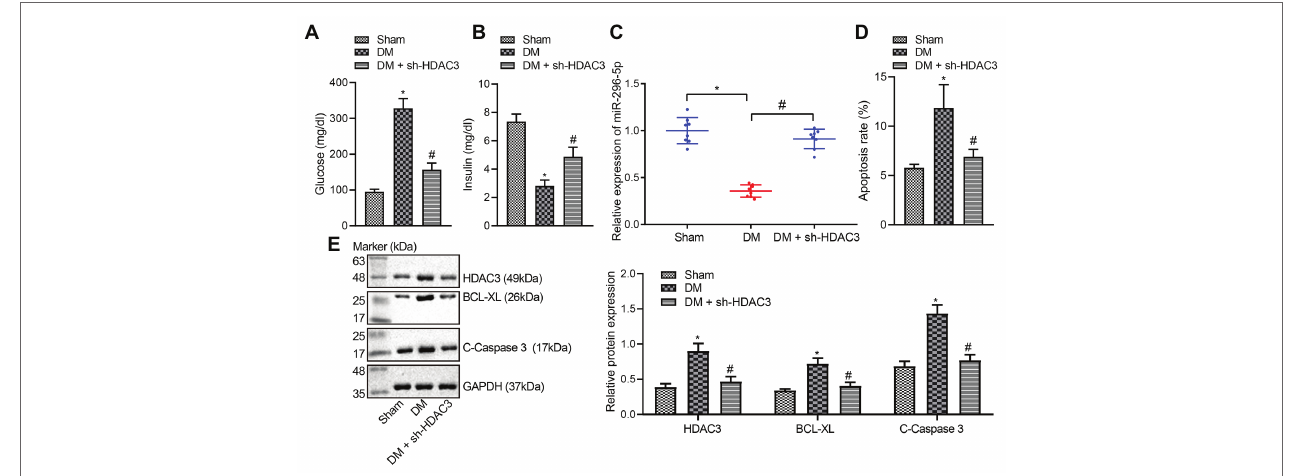
FIGURE 6 | shRNA-mediated silencing of HDAC3 alleviates DM-induced PBMC apoptosis in vivo . (A) Glucose level of rats. (B) Insulin levels of rats. (C) miR-296-5p expression in PBMCs of rats determined by RT-qPCR. (D) Quantitative analysis of PBMC apoptosis identified by flow cytometric analysis. (E) The expression of HDAC3, BCL-XL, and C-caspase-3 in PBMCs normalized to GAPDH determined by Western blot analysis. * p < 0.05 compared with sham-operated rats, # p < 0.05 compared with rats with DM. Data comparisons among multiple groups were performed using one-way analysis of variance. n =